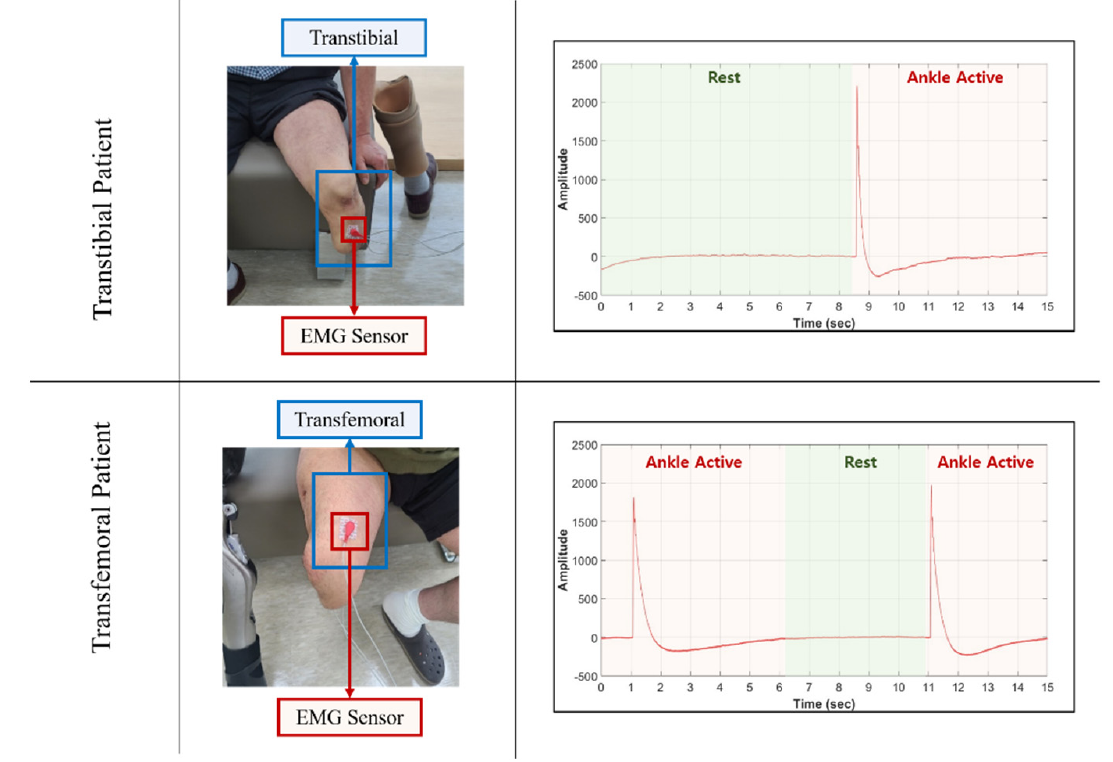
Figure 10. EMG Sensor Attachment and Extracted EMG Signal Graph.